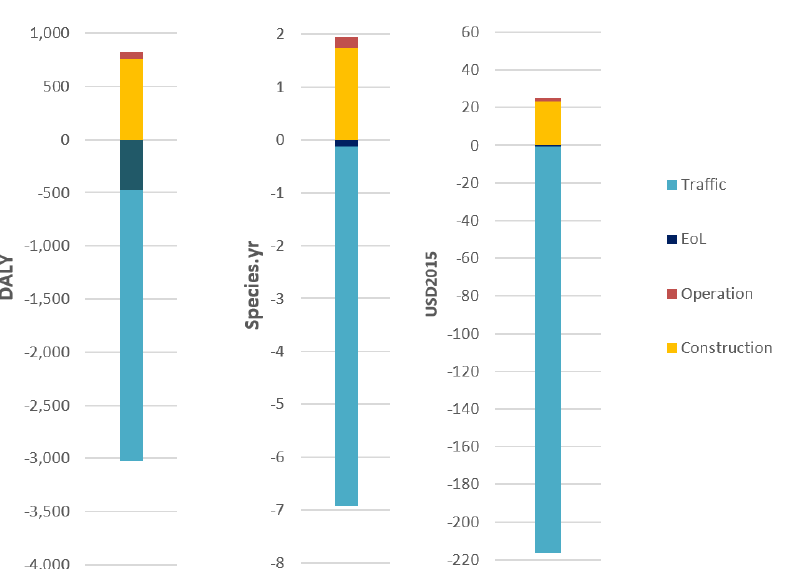
Figure 2. LCA impacts on human health (DALY), environment (Species.yr) and resource scarcity (million USD2015) by system